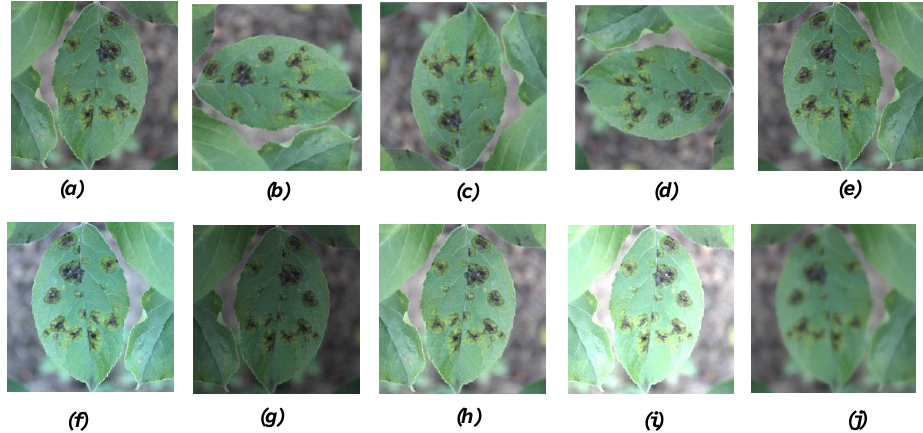
Figure 3. Different image augmentation methods: ( a ) original image, ( b ) 90 ◦ ACW rotation, ( c ) 180 ◦ ACW rotation, ( d ) 270 ◦ ACW rotation, ( e ) horizontal mirror projection, ( f ) color balancing, ( g – i ) brightness transformation, and ( j ) blur